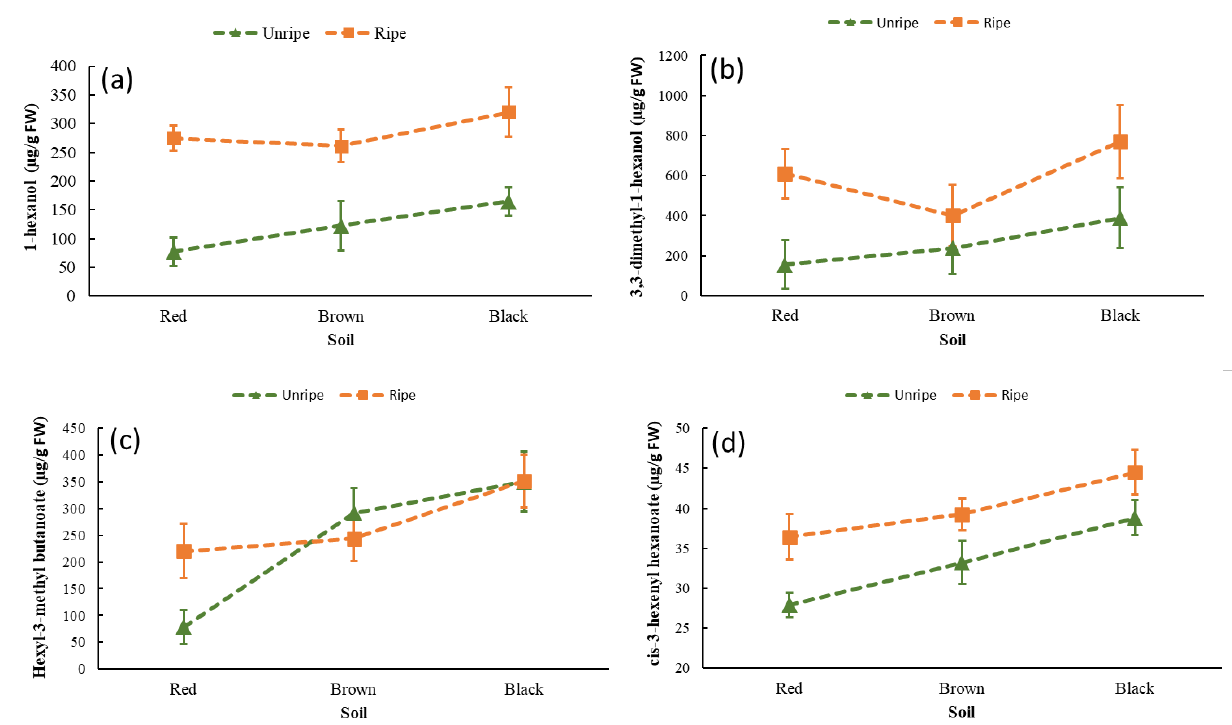
Figure 1. Interaction plots of the factors (soil and degree of ripeness) on the concentration of volatile compounds: ( a ) 1-hexanol, ( b ) hexyl-3-methyl butanoate, ( c ) 3,3-dimethyl-1-hexanol, ( d ) cis-3-hexenyl hexanoate. The error bars represent the standard uncertainty ( p ≤ 0.05). The average values of the volatile compounds found in both varieties (Mayapan and Jaguar) were used. The concentration of volatile compounds is expressed on a fresh weight (FW) basis.